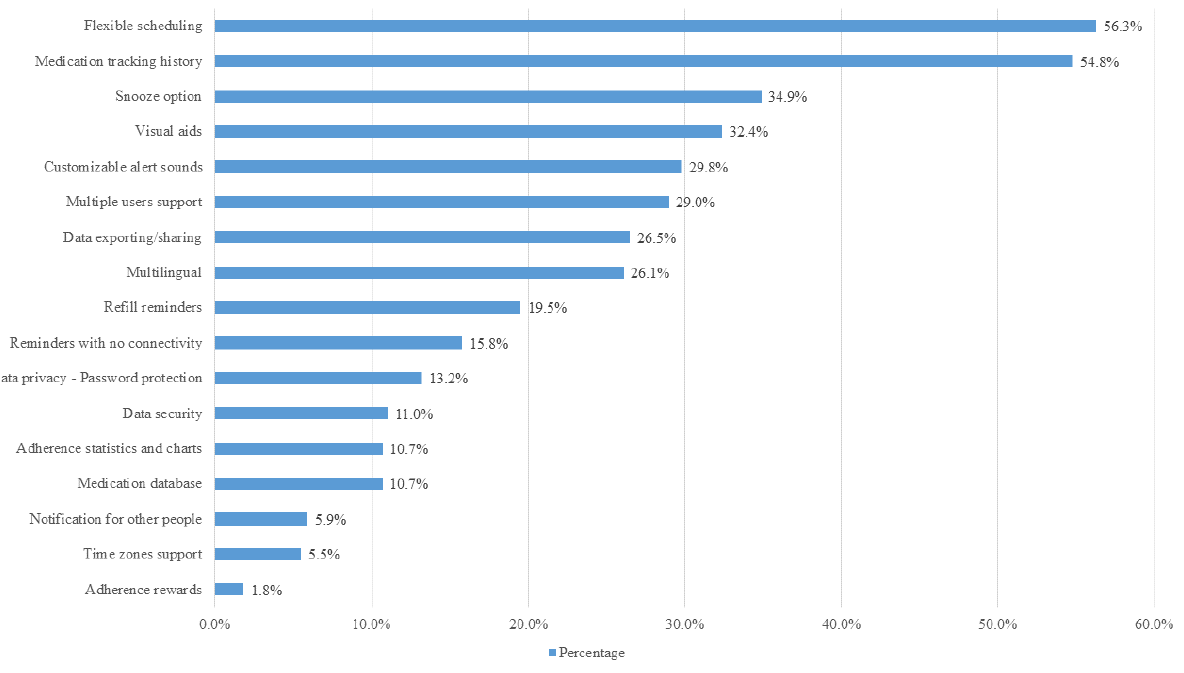
Figure 2. Results of functionality criteria